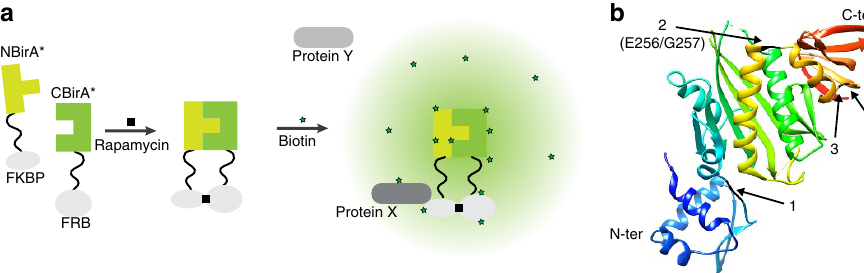
Figure 1 | Design of split-BioID. ( a ) Schematic drawing of the proof-of-principle set-up for split-BioID. FRB fused to CBirA* and FKBP fused to NBirA* interact with each other on addition of rapamycin. ( b ) BirA crystal structure (Protein Data Bank 1BIB) showing the four tested splitting sites (1: Q65/L66, 2: E256/G257, 3: N270/F271 and 4: N273/R274), the optimal E256/G257 site is indicated (See Supplementary